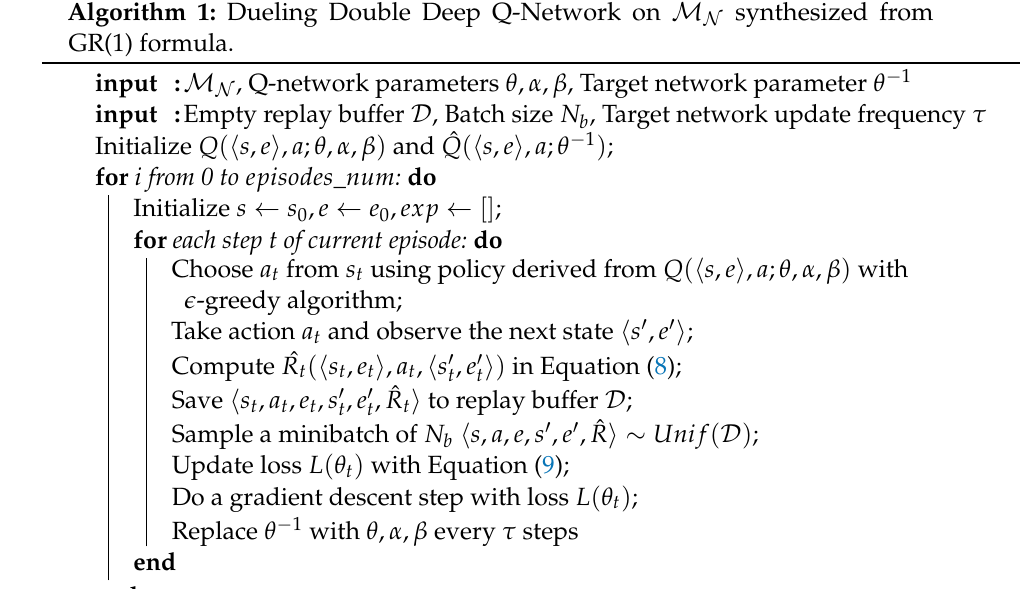
synthesized from M N